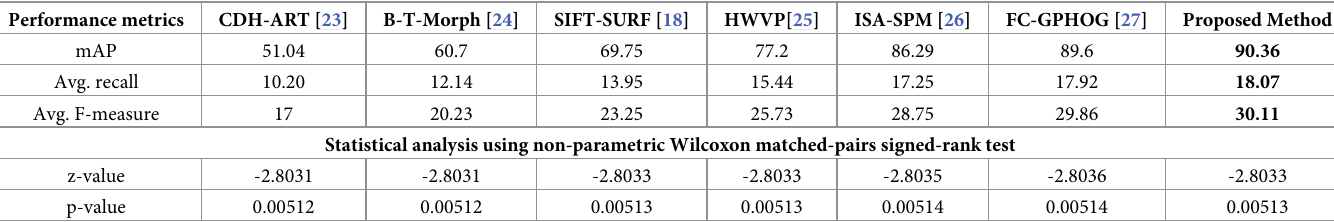
Table 5. Performance comparison of the proposed method with state-of-the-art methods on the OT Scene dataset. Performance metrics